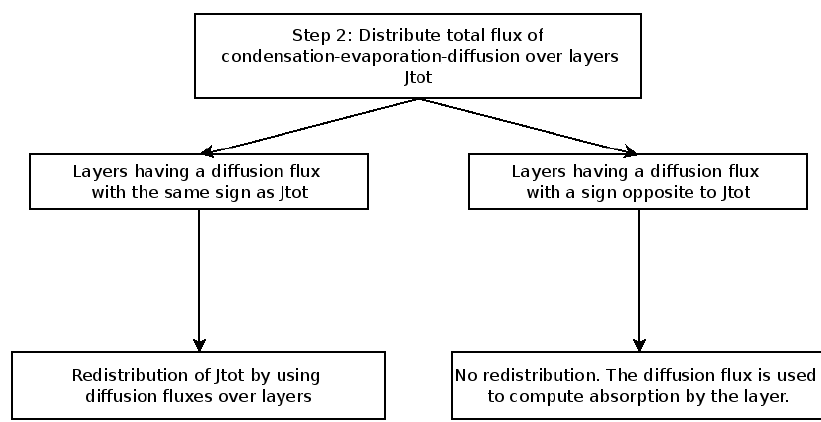
Figure 4. Diagram of the second step of the algorithm to compute evaporation–condensation–diffusion